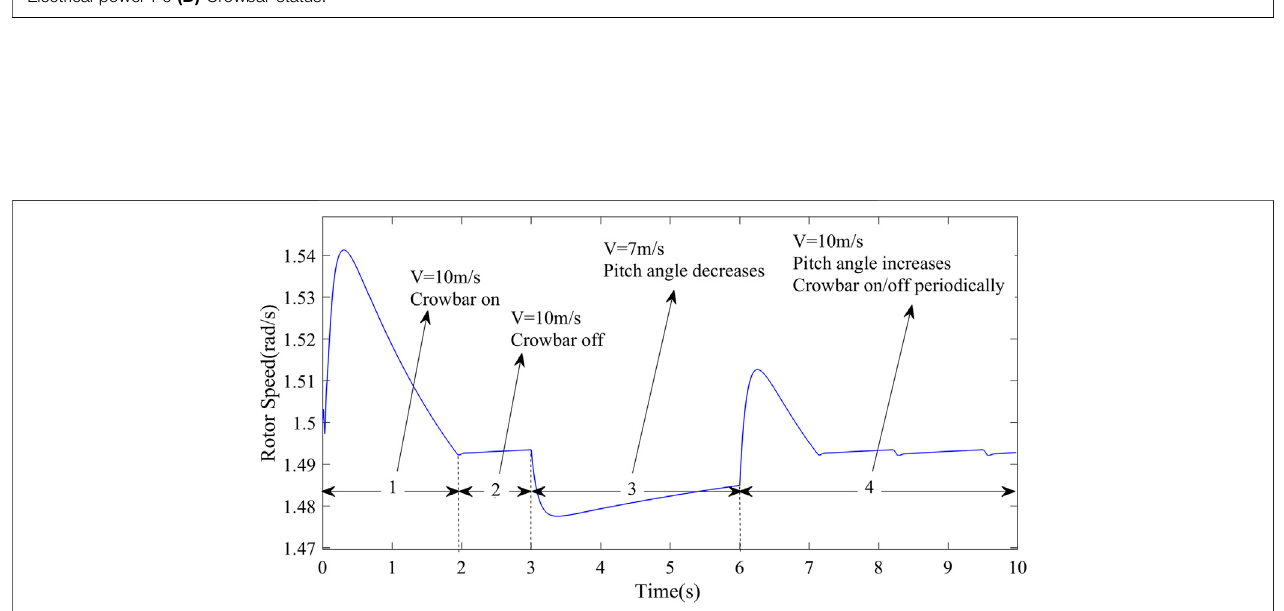
FIGURE 10 | The line-side voltage amplitude, rotor speed, electrical power, and crowbar status in case 2. (A) Line-side voltage amplitude (B) Rotor speed (C) Electrical power Pe (D) Crowbar status.